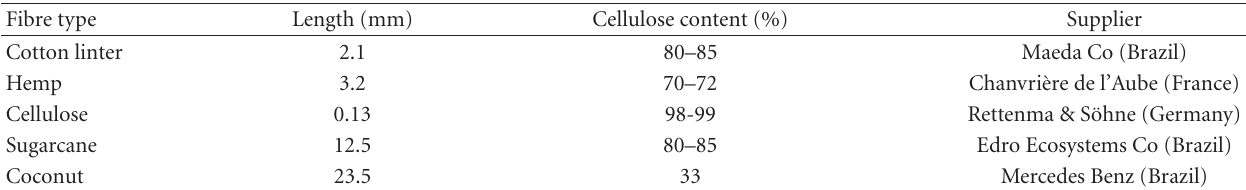
Table 1: Main characteristics of the di ff erent natural fibres used in this study.